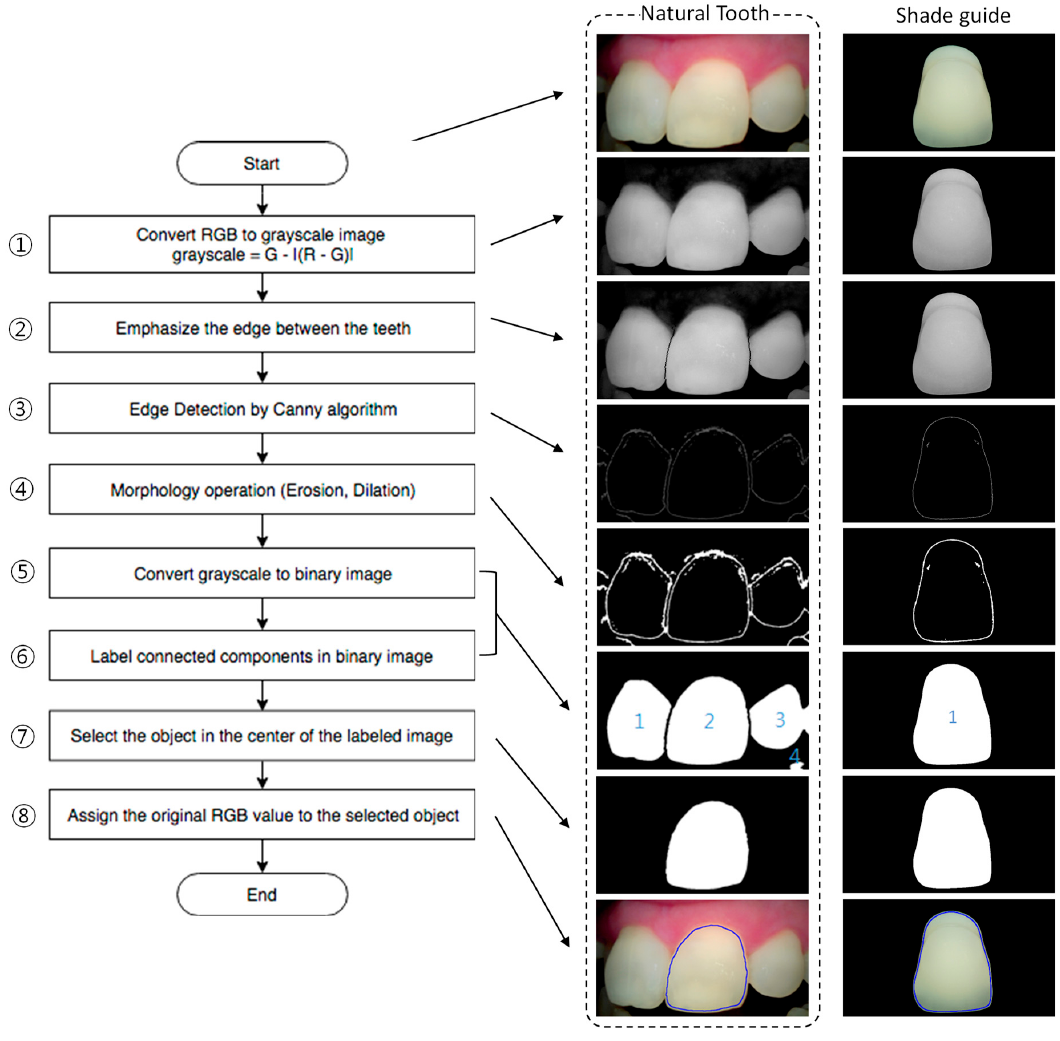
Figure 3. Edge detection procedure.